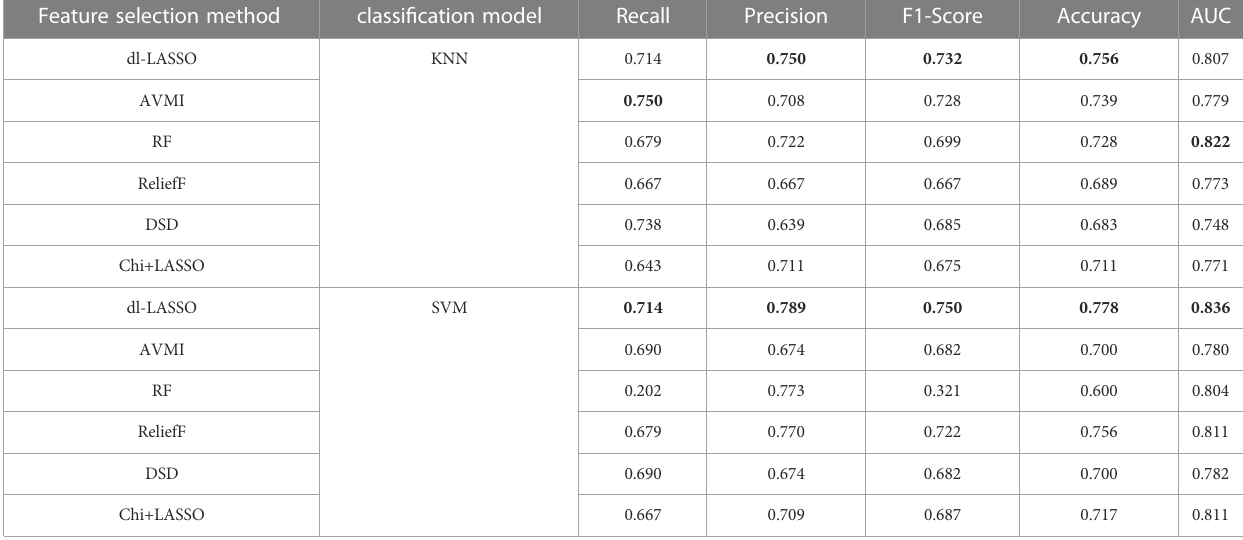
TABLE 4 The ROC curves of KNN and SVM classi fi